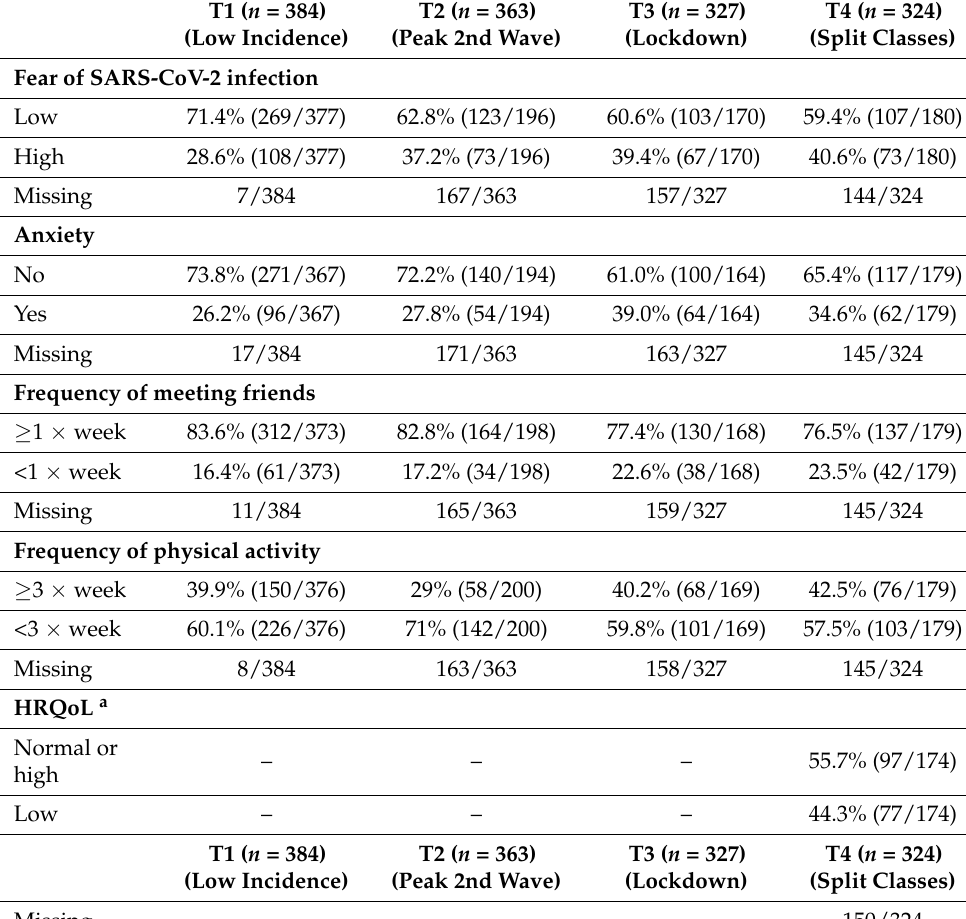
Table 1. Parameters related to psychosocial wellbeing among Berlin students, from June 2020 to March